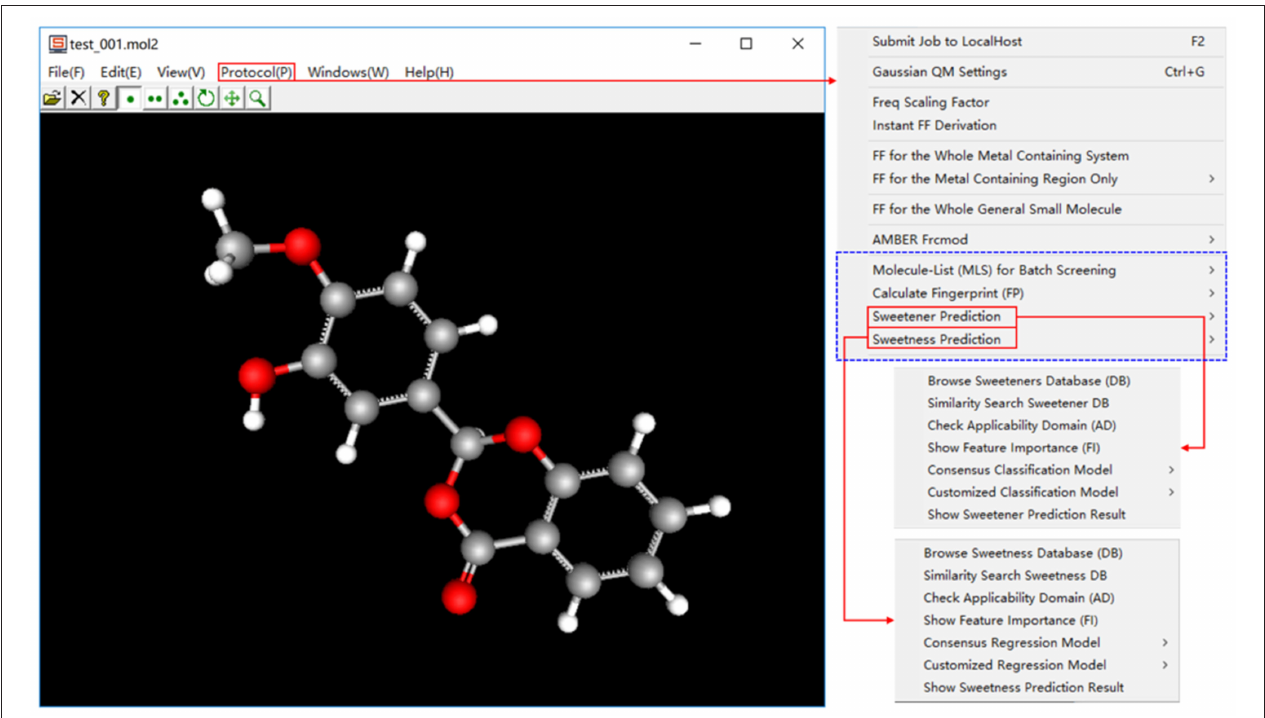
FIGURE 2 | The main features of e-Sweet platform for the sweetener and sweetness